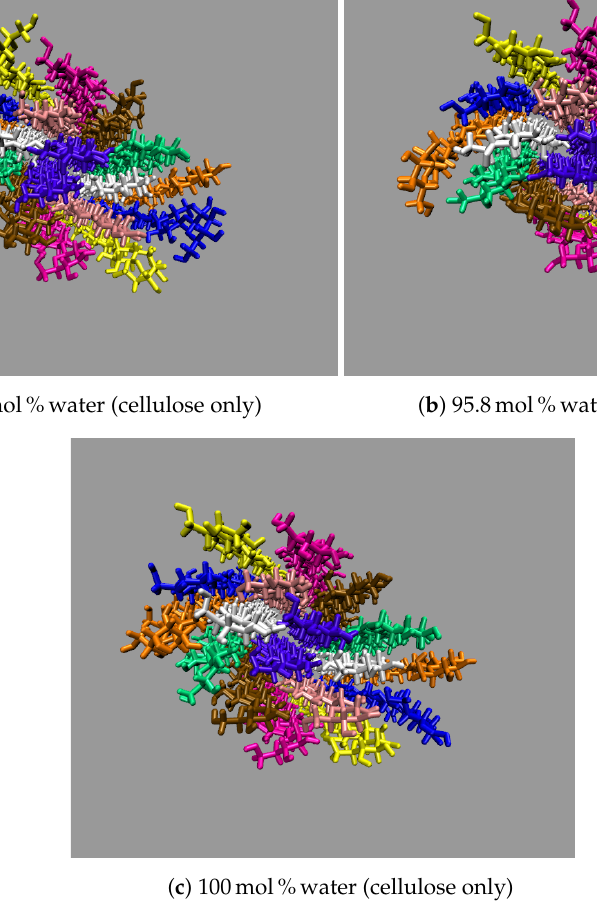
Figure A8. End view images of the cellulose bundle dissolution at 600ns, showing only the cellulose bundle (Part 2 of 2) at: ( a ) 93.9mol%water; ( b ) 95.8mol%water; and ( c )